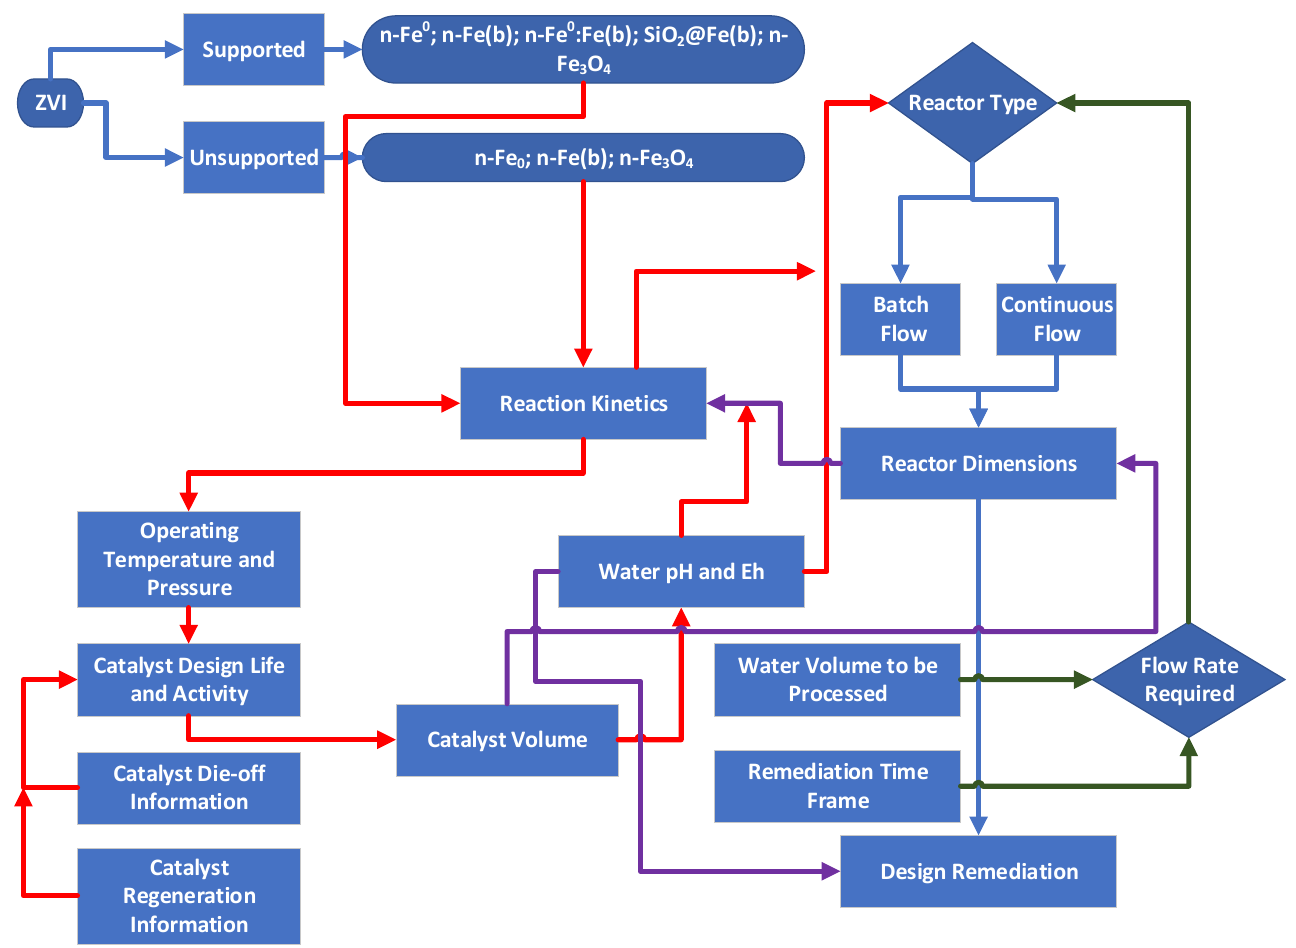
Figure 4. ZVI remediation flow chart, used to create a design remediation for a hydrodynamic stationary plume or a perched hydrodynamic groundwater mound. Fe(b) = iron oxyhydroxide polymers.